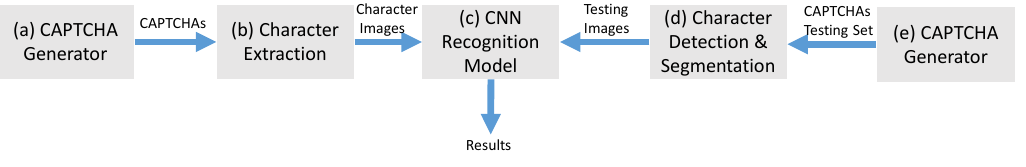
Figure 2. The work flow of our proposed framework. ( a ) Open-source libraries were modified to construct the CAPTCHA generator. ( b ) The generated CAPTCHA profiles were used to extract characters from the generated CAPTCHAs. ( c ) A CNN model was constructed for character recognition. ( d ) CAPTCHAs were generated for testing without saved profiles. ( e ) TOD and peak segmentation were used for segmenting the